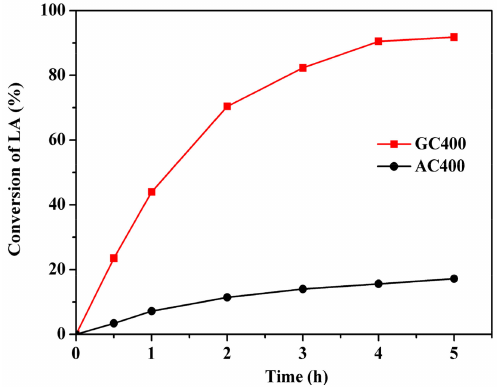
Figure 4. Conversions of LA over two sulfonated carbon materials as the function of reaction time. Reaction conditions: 1.16 g LA, 3.7 g n-butanol and 0.116 g catalyst, 373 K, 4